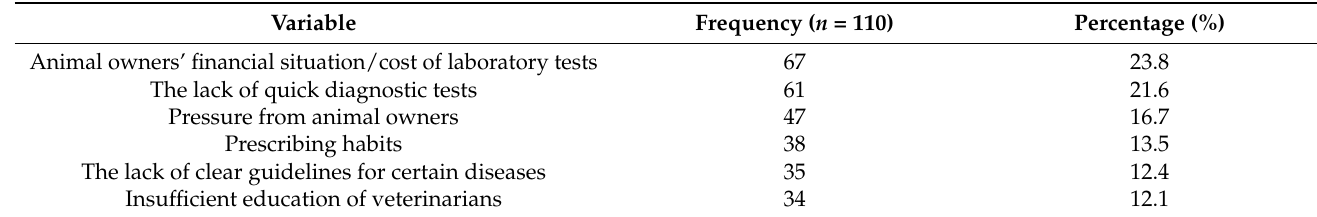
Table 8. Reasons for prescribing antibiotics without a clear